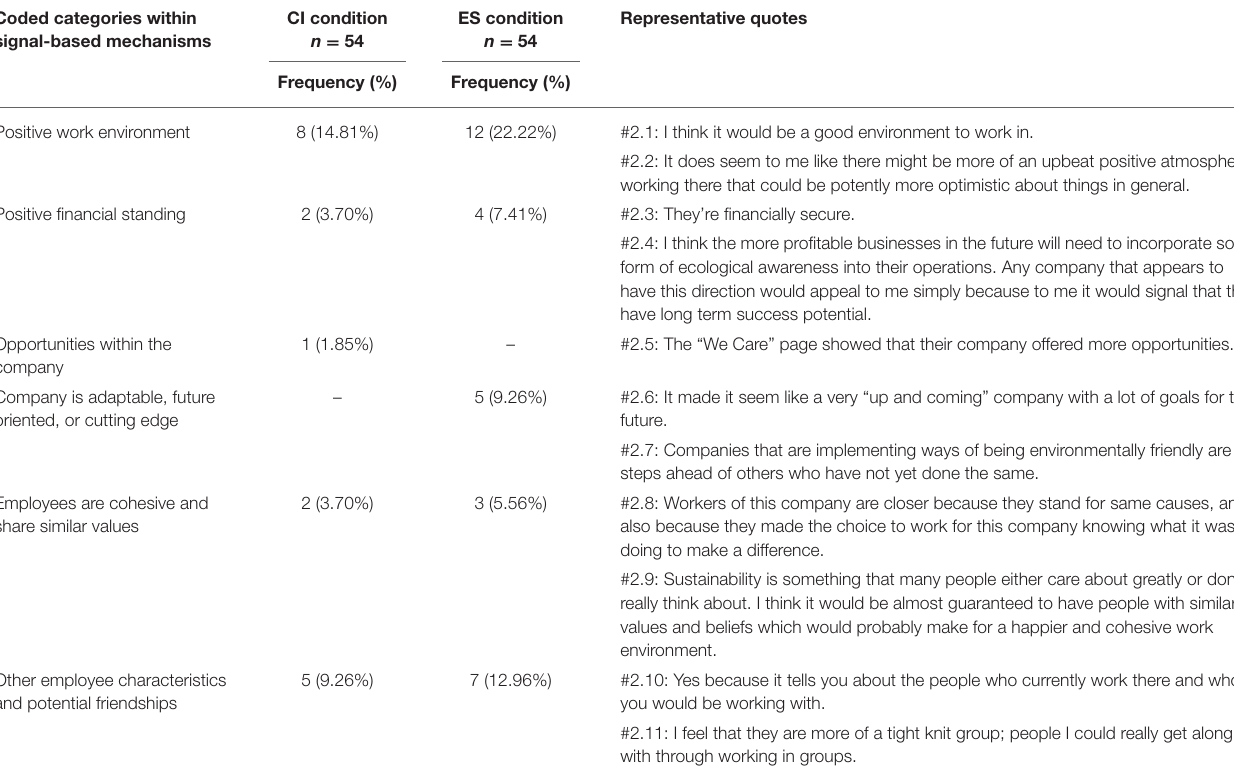
Coded categories within signal-based